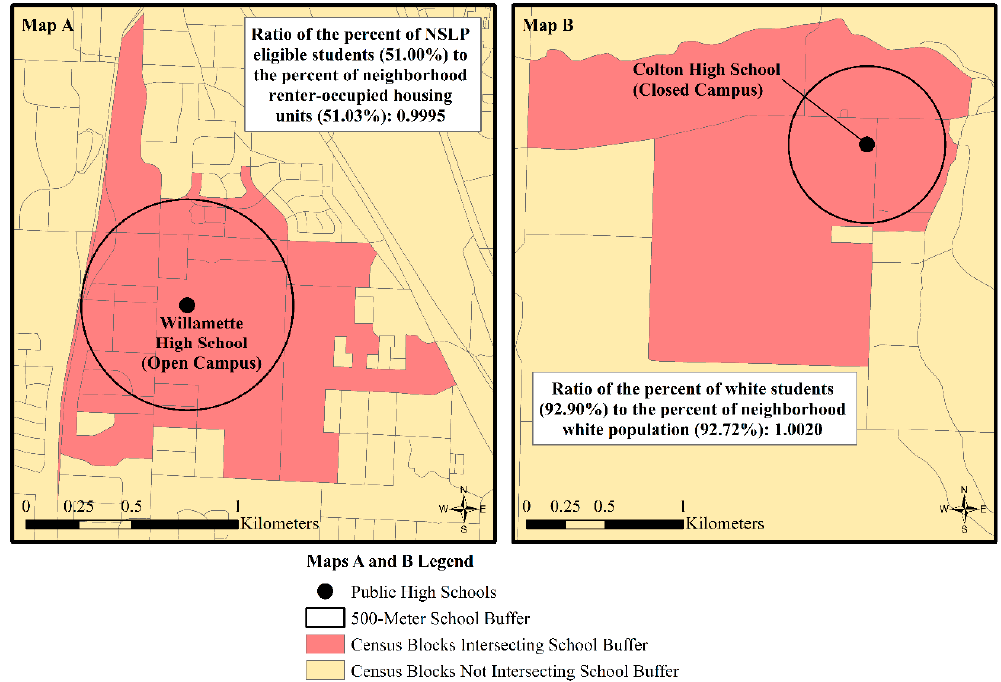
Figure 2. Illustration of census block intersection with a 500-m buffer for Oregon public high schools to derive Oregon public high schools’ social environment variables of ( A ) socioeconomic status similarity and ( B ) racial similarity.